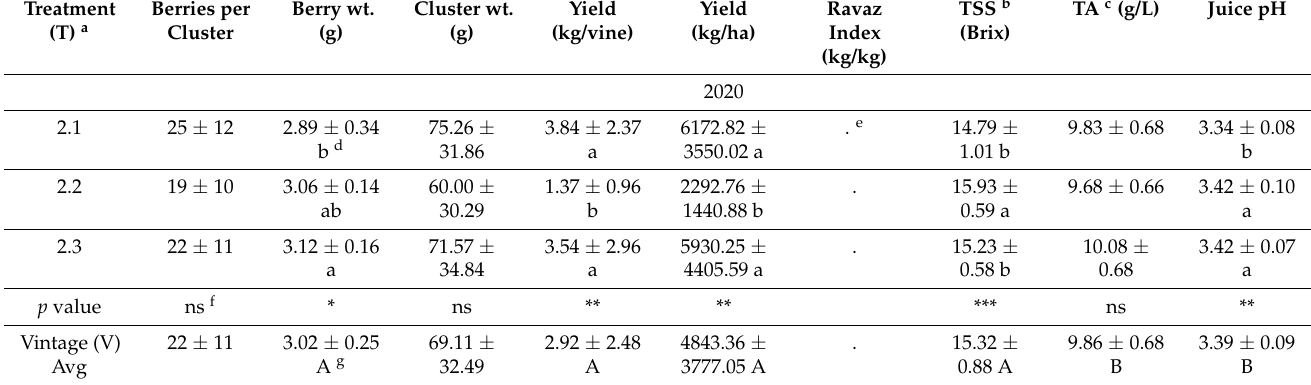
Figure 5. Weekly average ‘MidSouth’ total soluble solids (TSS) and titratable acidity (TA) for each treatment in Study 2 from veraison to harvest in 2020 ( A ) and 2021 ( B ) in McNeill, MS. LR, leaf removal; ST, shoot thinning; Control, no leaf removal or shoot thinning. The only measured variables that differed by both treatment and vintage were yield per vine and juice pH. While yield per vine was highest for leaf removal vines (T2.1) in 2020, it was lowest for leaf removal vines in 2021, and juice pH appeared to be stable among each vintage (Table 4). Juice pH was lowest in leaf removal vines (T2.1) in 2020, and all treatments (T2.1, T2.2, T2.3) had higher pH values in 2021 than 2020 (Table 4). Table 4. ‘MidSouth’ mean ± standard deviation yield components and grape composition for each treatment, vintage, and treatment and vintage interaction in Study 2 in McNeill, MS (2020 and 2021).